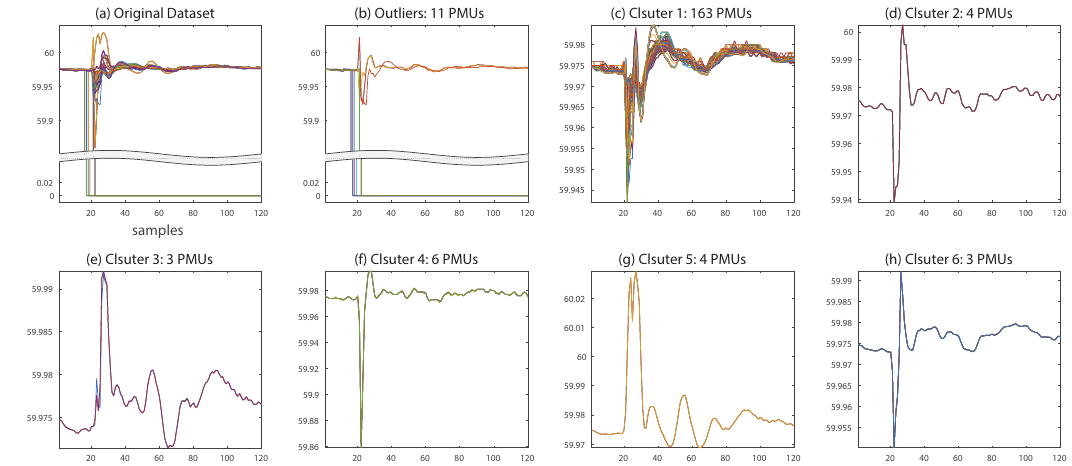
Figure 5. Clustering result of frequency data containing an event and bad data. ( a ) Original dataset, ( b ) outliers, ( c – h ) clustered PMU datasets by